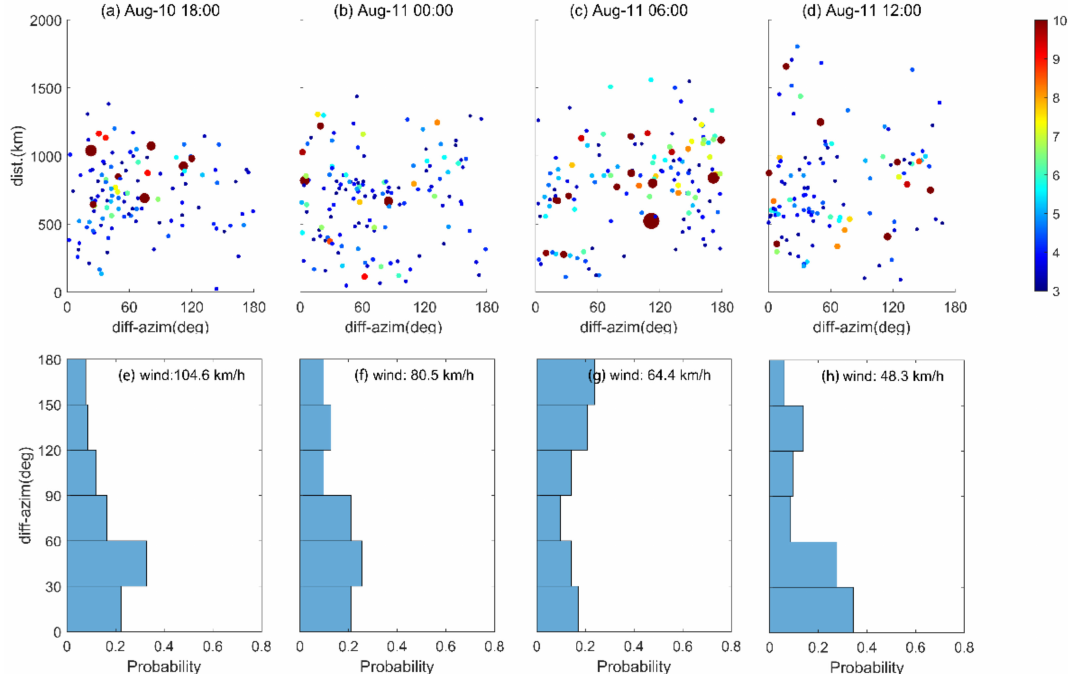
Figure 9. ( a – d ) Scatter of azimuth differences with distance between station and typhoon eye at UTC time 10 August 18:00, 11 August 00:00, 11 August 06:00 and 11 August 12:00, respectively; ( e – h ) probability histogram of azimuth differences at the four corresponding time